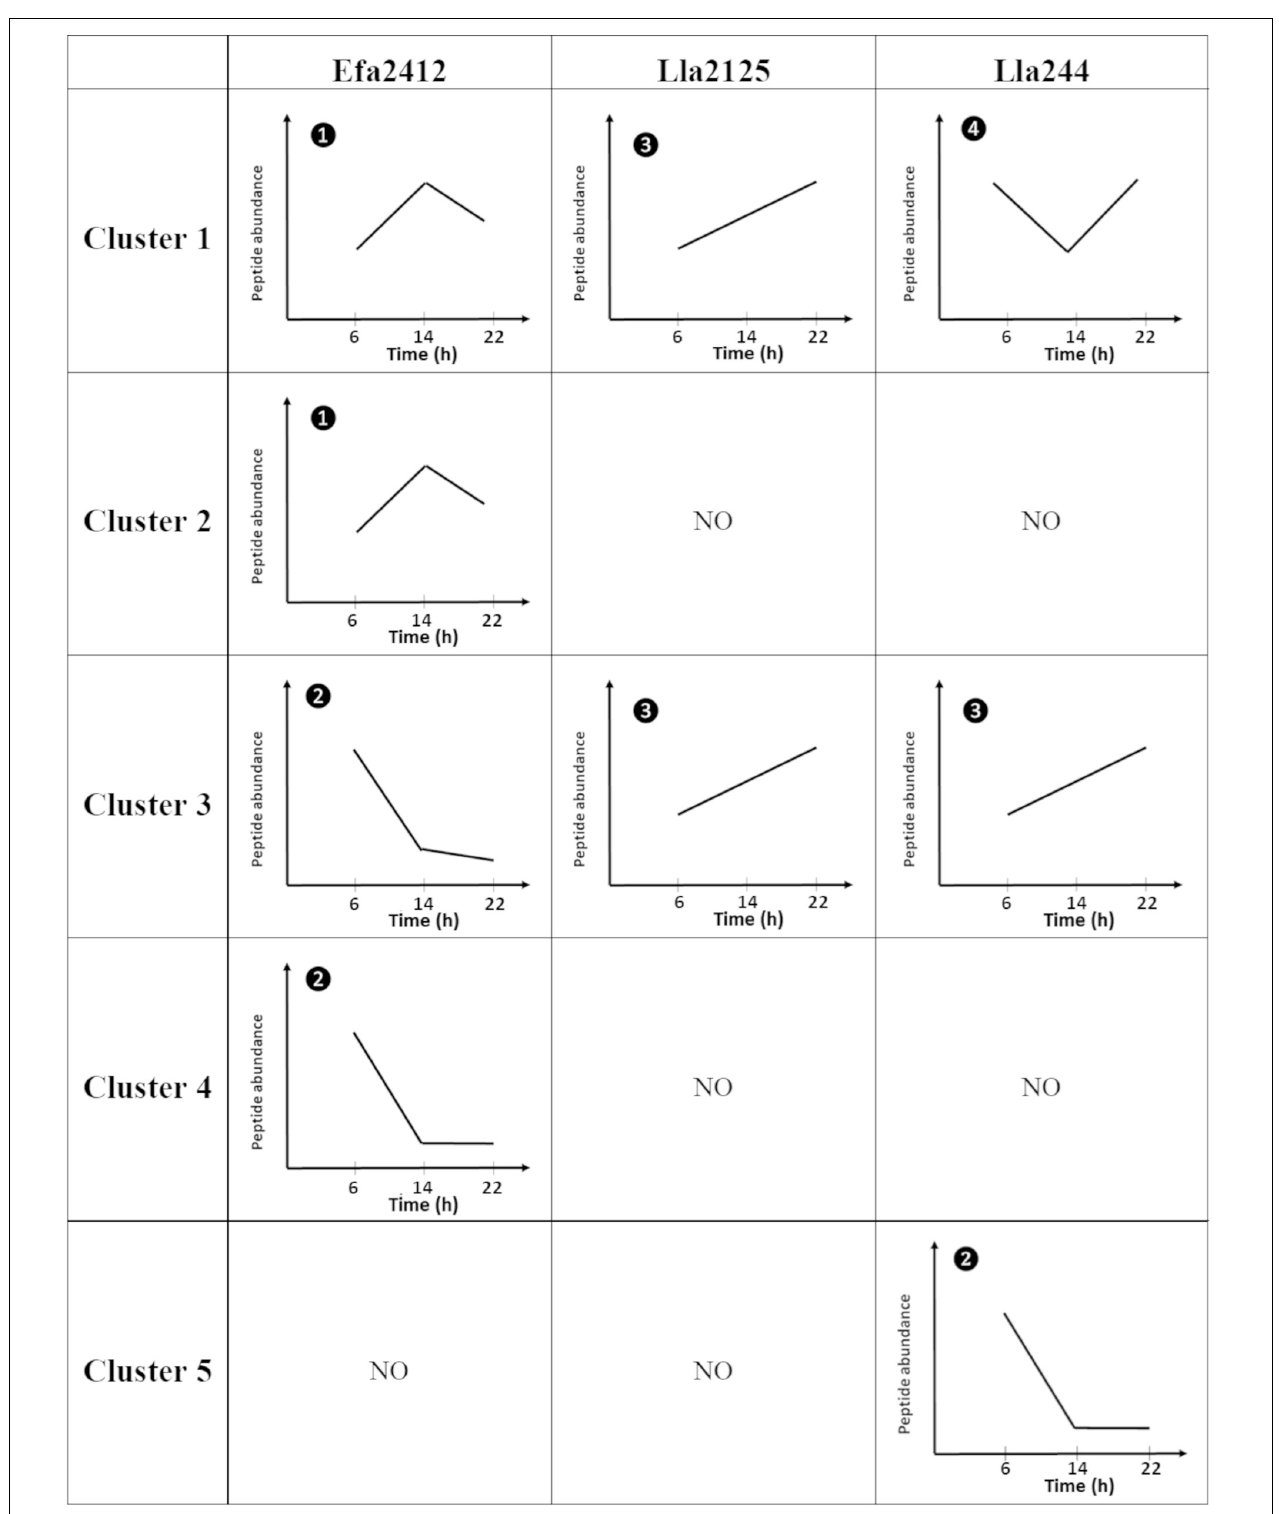
FIGURE 5 | Representation of the global kinetic profiles of the peptides according to the five clusters depicted in Figure 4 and the three donor strains. The variations represented were statistically significant for each time (Friedman test, p -value < 0.05). (cid:202) Peptides accumulated then decreased; (cid:203) peptides decreased until they are no more detected; (cid:204) peptide continuously accumulated; (cid:205) peptides decreased then accumulated. An accumulation means that peptides were produced faster than they were further cleaved or/and used, while a decrease means that they were cleaved or/and used faster than they were produced. NO, not observed.